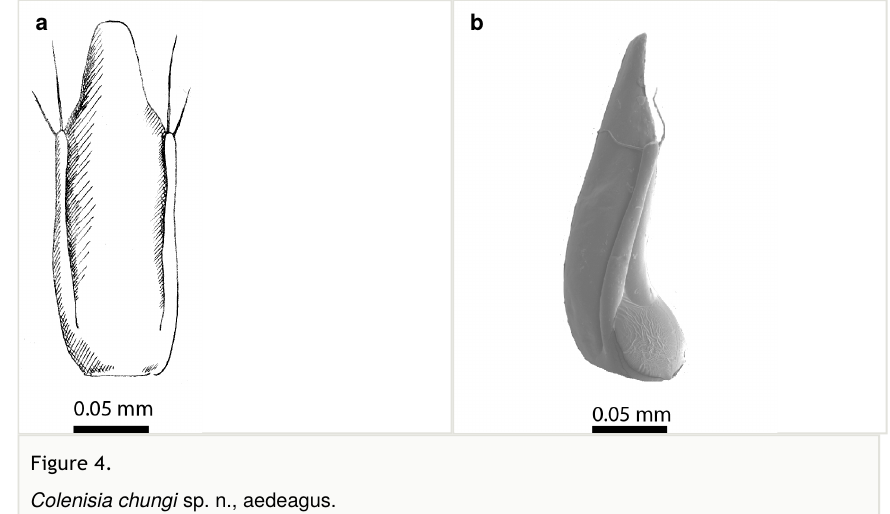
Colenisia chungi sp. n., aedeagus. a : Male, aedeagus, dorsal view (drawn after electron micrograph) (paratype, FRCS) b : Male, aedeagus, lateral view (paratype, FRCS)